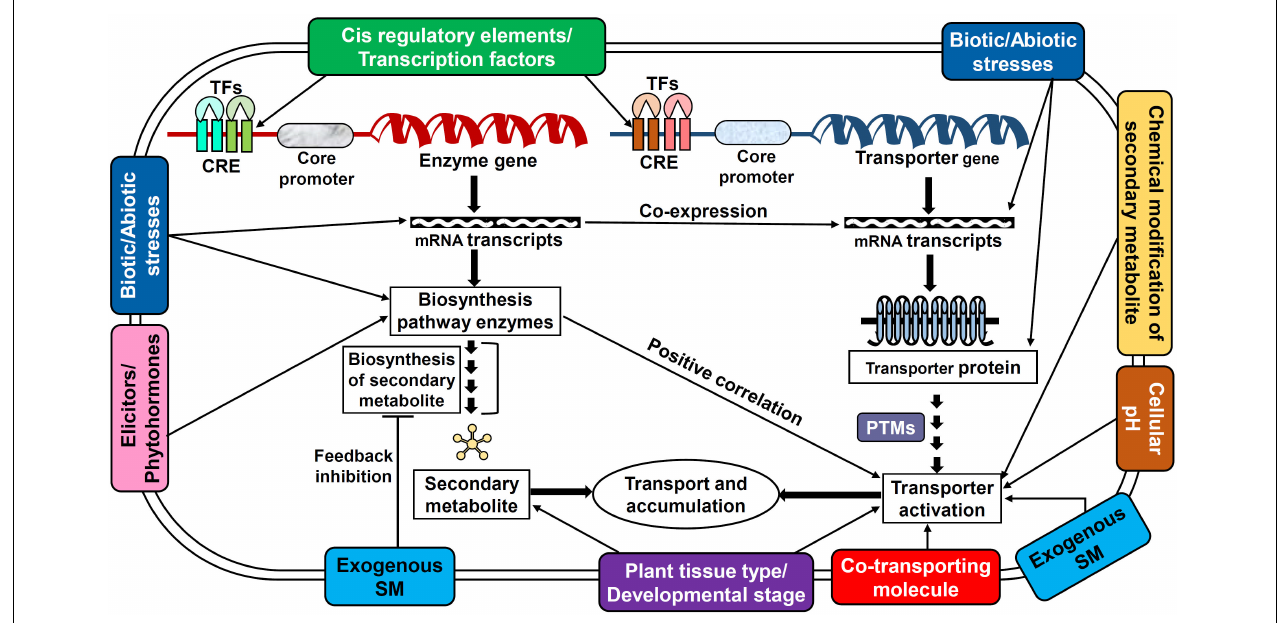
FIGURE 3 | Potential regulatory mechanisms employed by several key factors affecting the transporter functioning in plants. This model displays the interaction of various regulatory factors with secondary metabolite biosynthesis and transporter protein expression/activation. The interactions also depict the possible cross-talks between metabolite biosynthesis and transporter expression. CRE, cis -regulatory elements; PTM, post-translational modifications; SM, secondary metabolite; TF, transcription